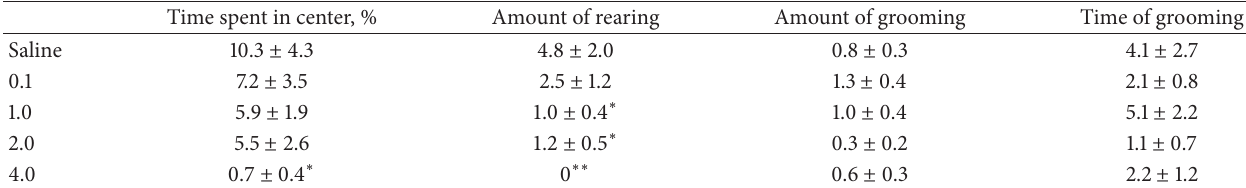
Table 1: Behavior of CBA mice treated with MK-212 and saline in the open field test.